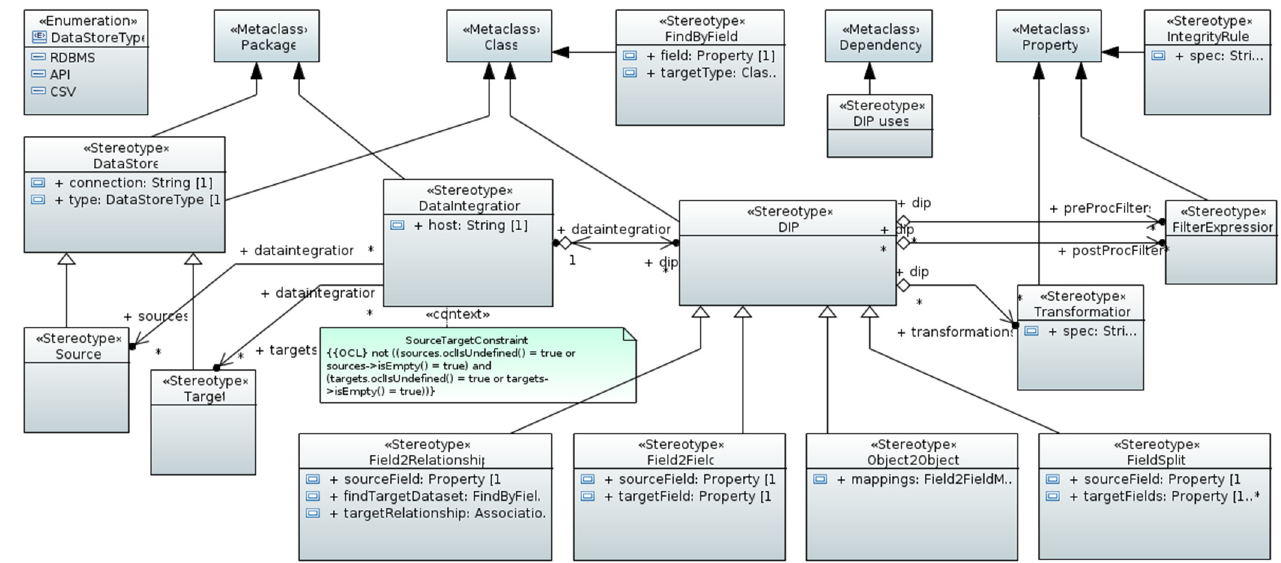
Figure 6. DIP Profile (definition of stereotypes and tagged values) on the meta-level (M2).